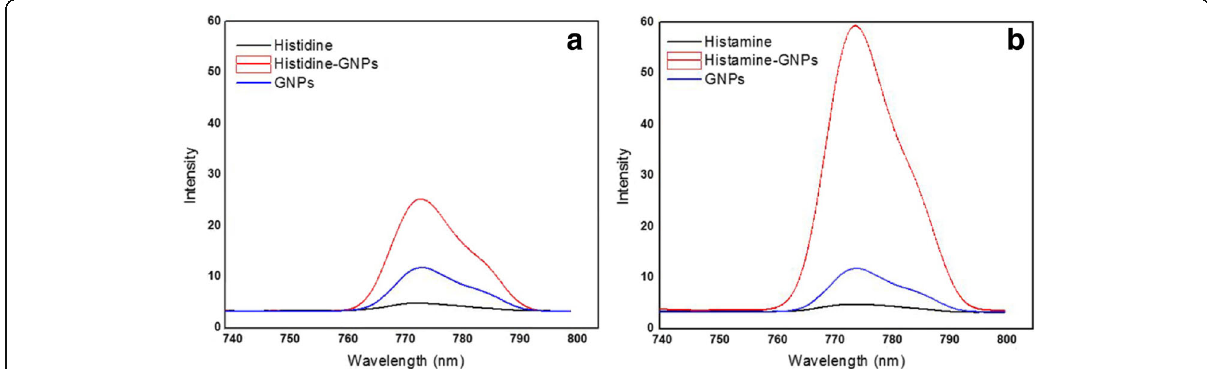
Fig. 3 Fluorescence spectra of a histidine – GNPs and b histamine –